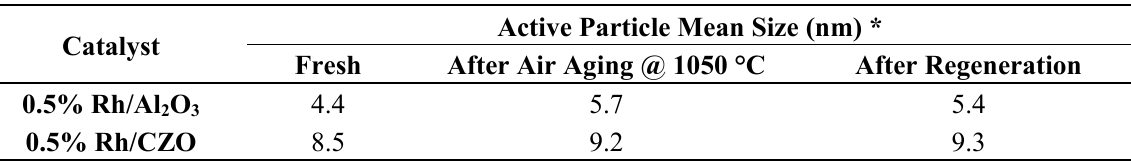
Table 4. Mean metal particle sizes (nm) of fresh and aged TWCs as measured using TEM images.